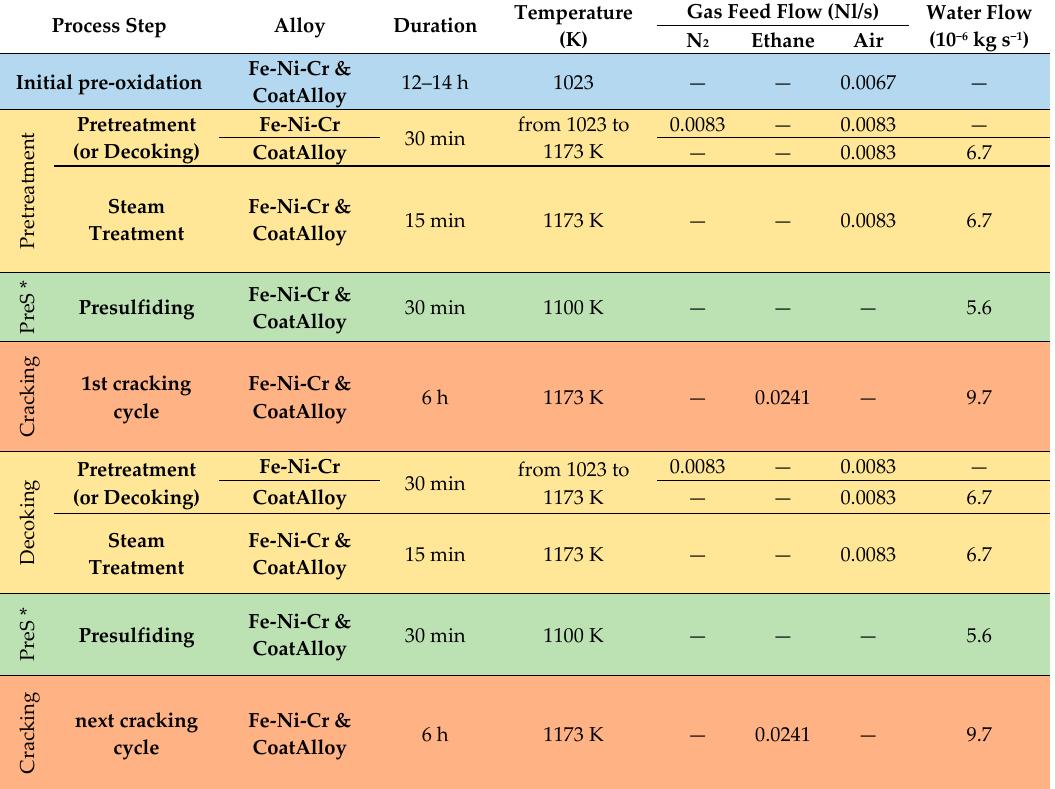
Table 2. Schematic overview of the coking-decoking experiments with cyclic aging.